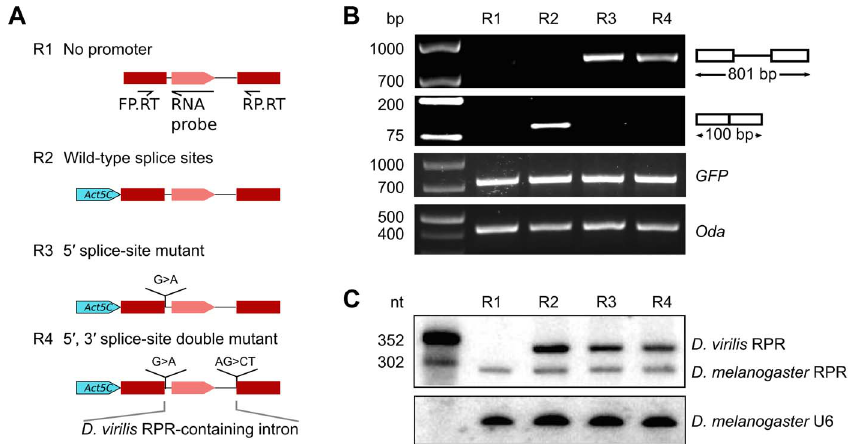
Fig. 2. RPR is processed from a recipient intron. Various RFP reporter genes harboring the RPR - coding D. virilis intron were expressed in D. melanogaster S2 cultured cells to define sequences required for biogenesis of RPR. A. Schematic showing the reporter genes tested. B. RFP pre-mRNA and mRNA were analyzed by RT-PCR (using the primers FP.RT and RP.RT indicated in A). The presence of the protein was determined by fluorescent microscopy. C. RPR was detected by northern analysis. The antisense D. virilis RNA probe also detected the native D. melanogaster RPR because of sequence conservation. Controls used : GFP, expressed from a co-transfected plasmid to serve as a control for transfection efficiency; Oda (Ornithine decarboxylase antizyme) is a housekeeping transcript used to normalize input RNA for the RT-PCR experiment; U6 RNA was used as loading control the northern analysis.